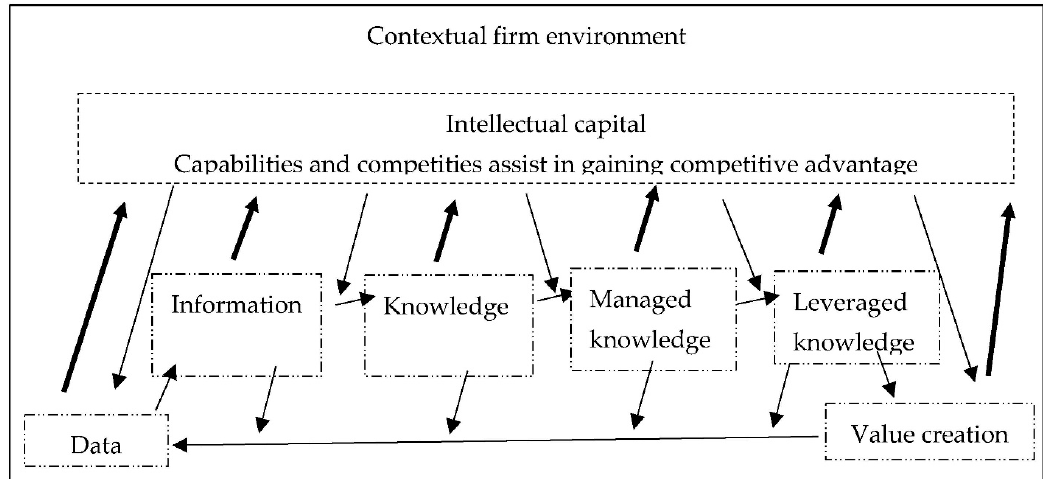
Figure 6. Data to value creation.